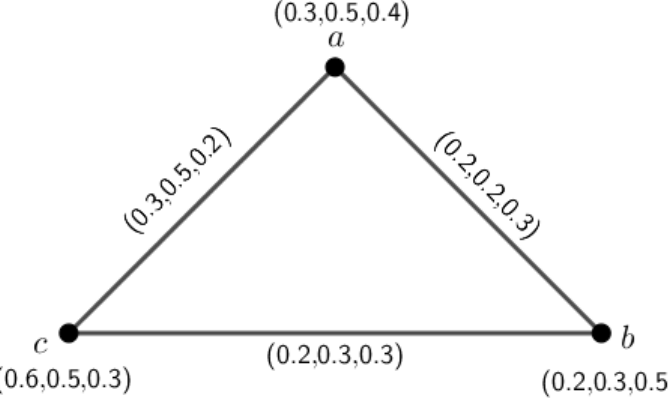
Figure 4. Efficient 3PFG Γ